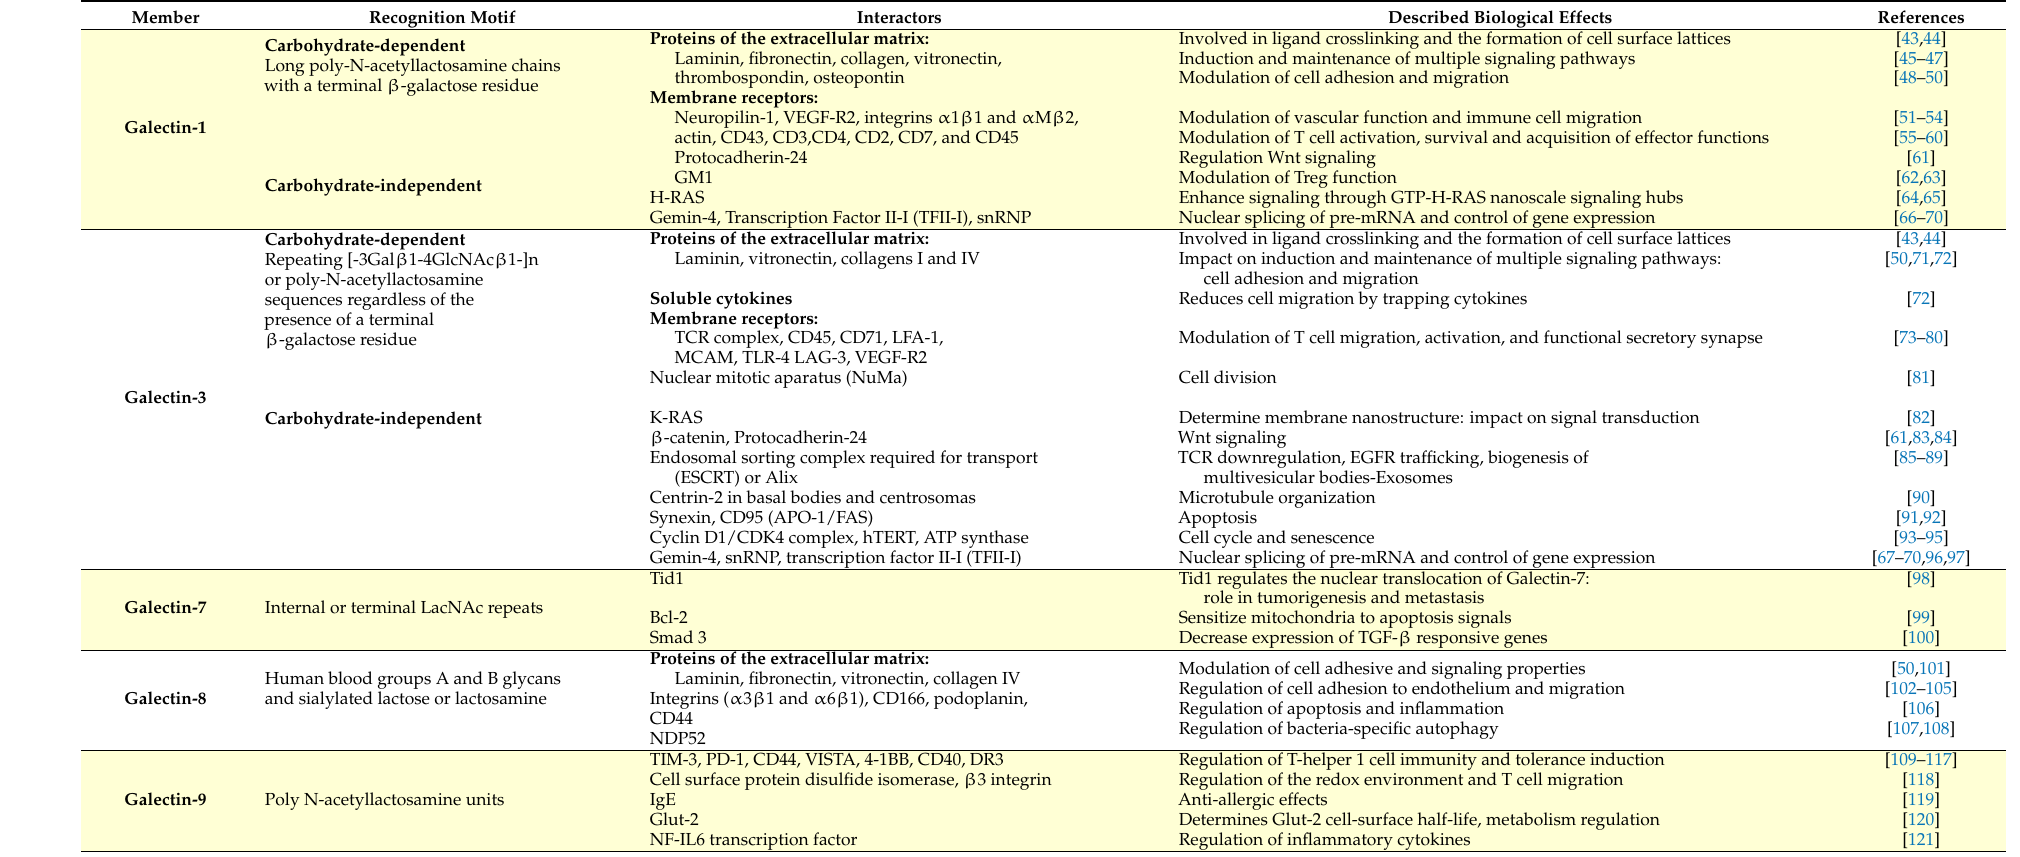
Table 1. The galectins’ interactors and their impact on cancer immune